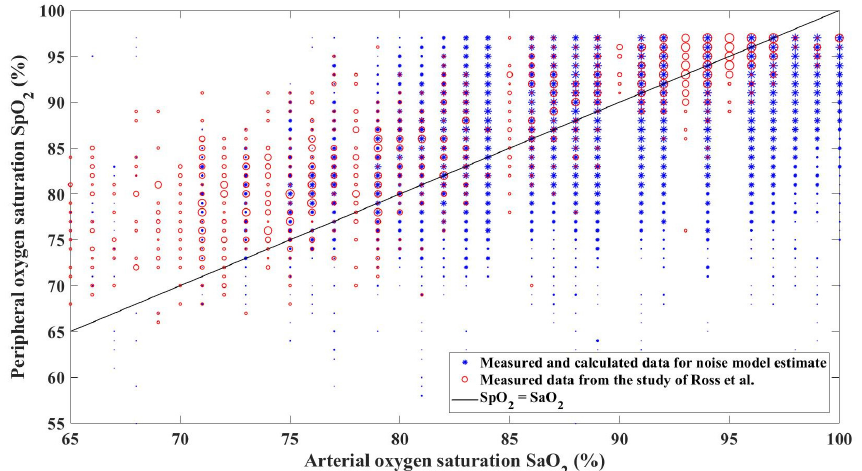
Figure 5. Comparison of SaO 2 –SpO 2 scatterplots from the data for the noise model estimate and the data acquired by Ross et al. [11]. The diameter of a marker for each SaO 2 –SpO 2 pair is proportional to the frequency of the value occurrence.